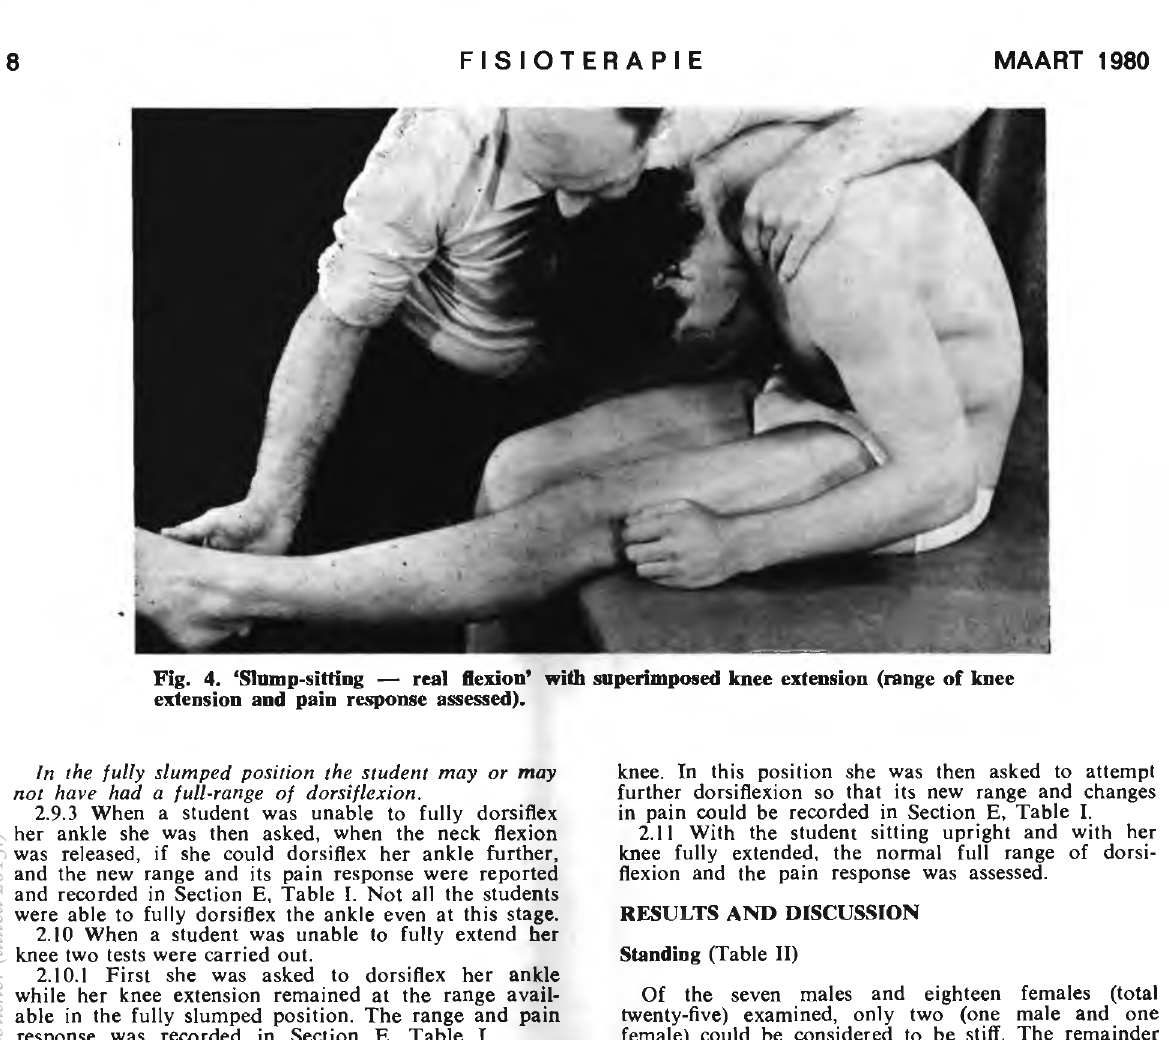
In the fully slumped position the student may or may not have had a full-range of dorsiflexion.